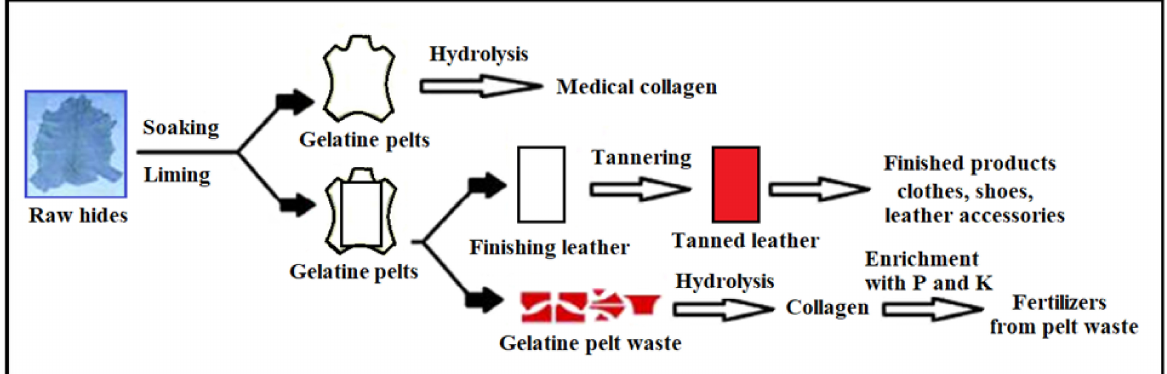
Figure 4. Differences in the preparation of medical collagen and agricultural collagen, readapted from